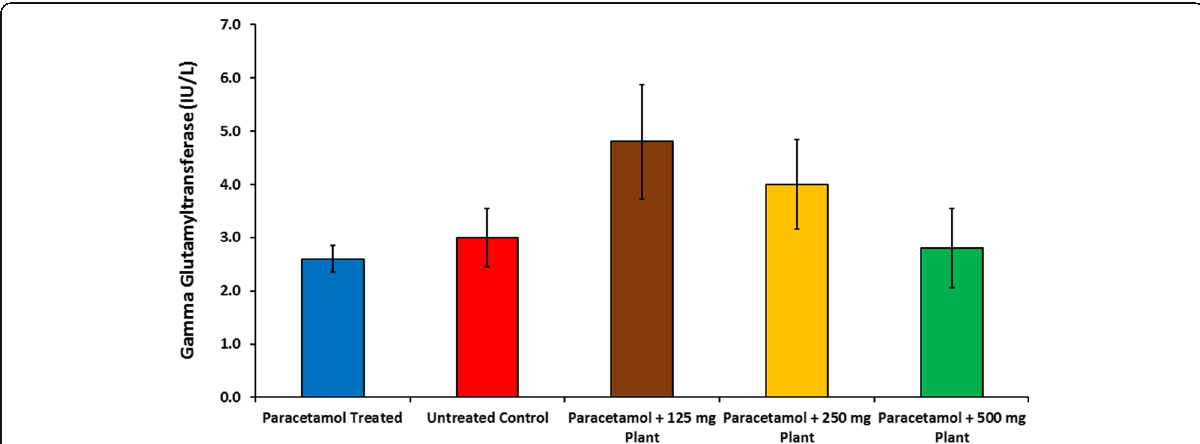
Fig. 4 Bar charts showing the effect of A. orientalis on serum GGT in paracetamol treated, untreated control, paracetamol A. orientalis pretreated 125, 250, 500 mg/kg BW mice groups. Note that in all doses GGT levels were insignificantly increased compared to paracetamol treated mice group. Data are presented as: mean ± SEM, n =